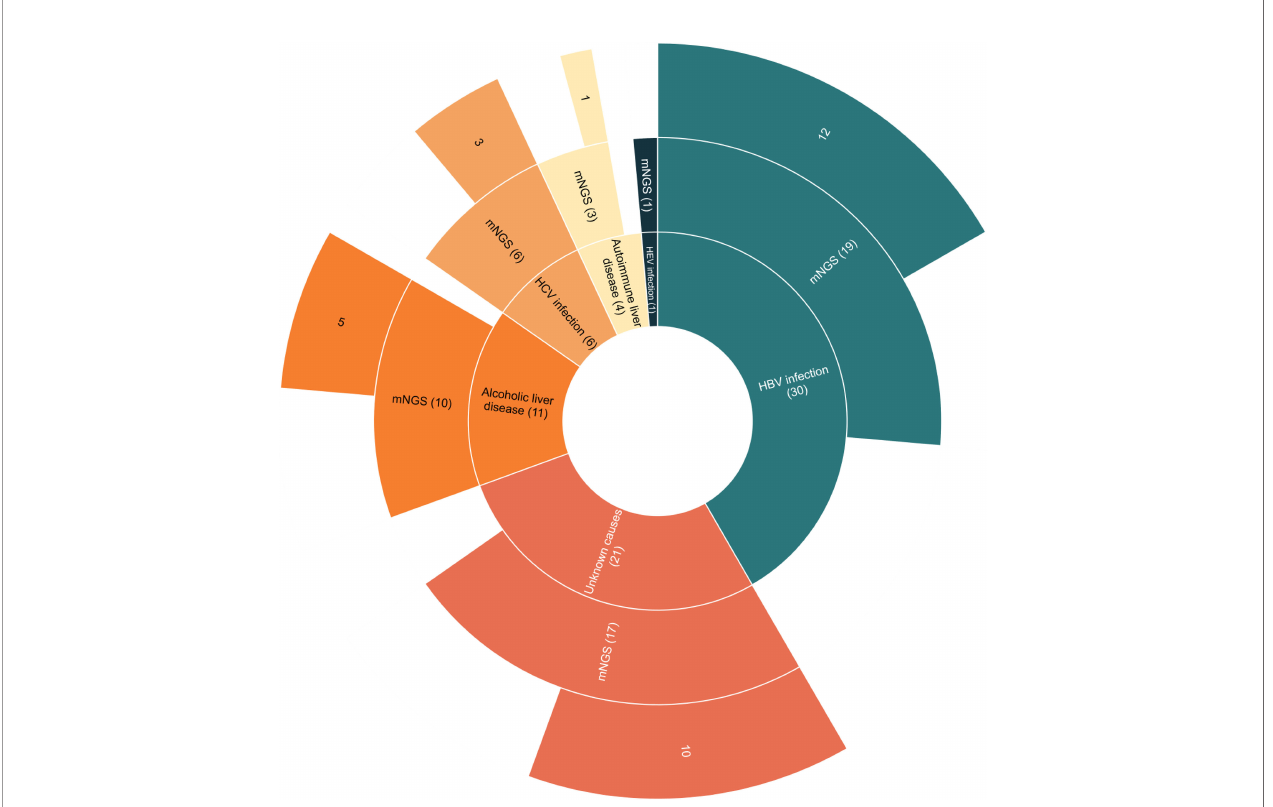
FIGURE 2 | The metagenomic next-generation sequencing (mNGS) results of suspected thoracic and abdominal infection patients with different causes of end- stage liver disease (ESLD). Patients with ESLD of different causes were shown in the inner circle. Patients with detected pathogens by mNGS were shown in the middle circle. Patients with positive results by mNGS were shown in the outer